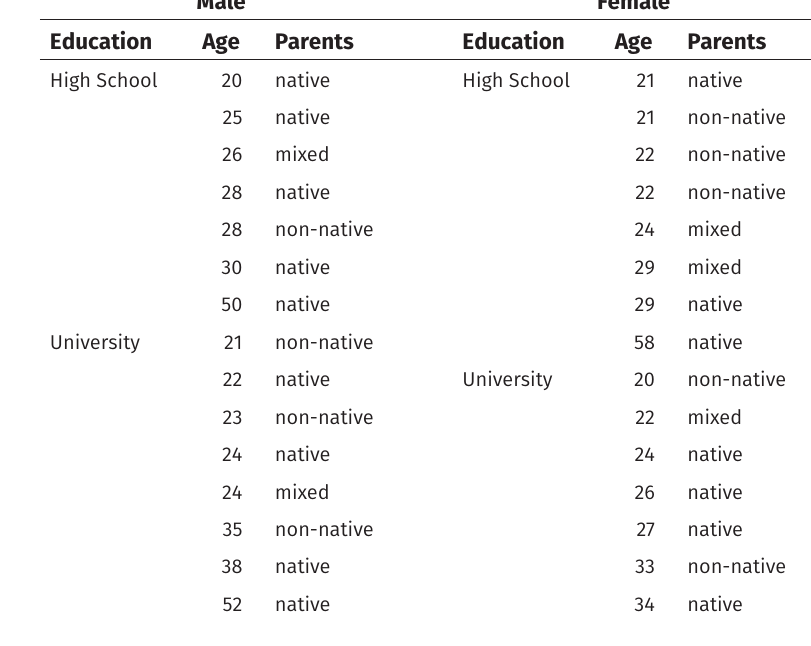
Table 2: Social profile of